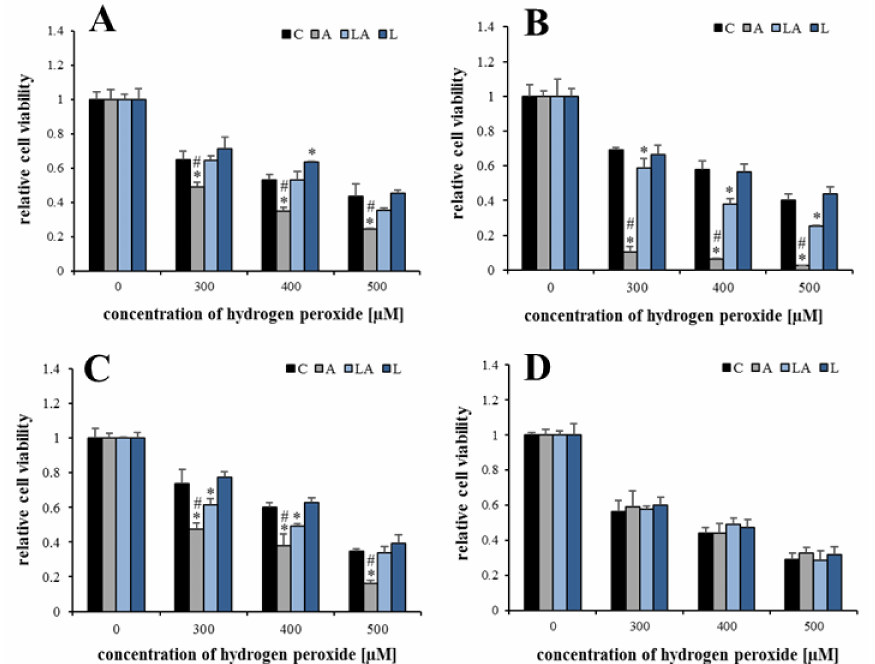
Figure 2. The effect of adaptation time on cell sensitivity to oxidative insult. PaTu-8902 cells were treated with experimental media for ( A ) 6 h, ( B ) 14 days, and ( C , D ) 72 h followed by 4 and 48 h washout with the control medium, respectively. Then, the cells were treated with the indicated concentrations of hydrogen peroxide and their viability was measured by resazurin assay. C, control; A, acidosis; LA, lactic acidosis; L, high lactate (* p < 0.05 compared to C, # p < 0.05 when comparing A and